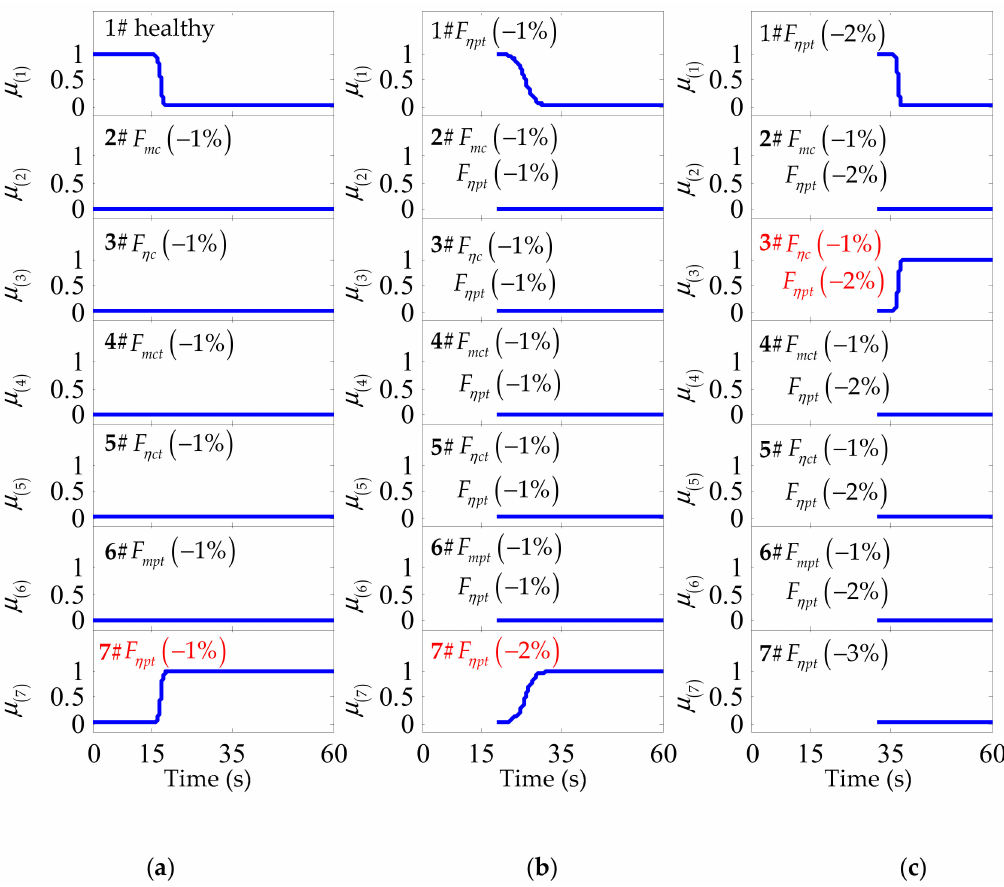
Figure 11. The multiple fault detection and isolation results for the scenarios of a 2% decrease in F η pt at t = 15 s and 1% decrease in F η c at t = 35 s. ( a ) The conditional probability of the initial model set; ( b ) The conditional probability of the updated model set 1; ( c ) The conditional probability of the updated model set